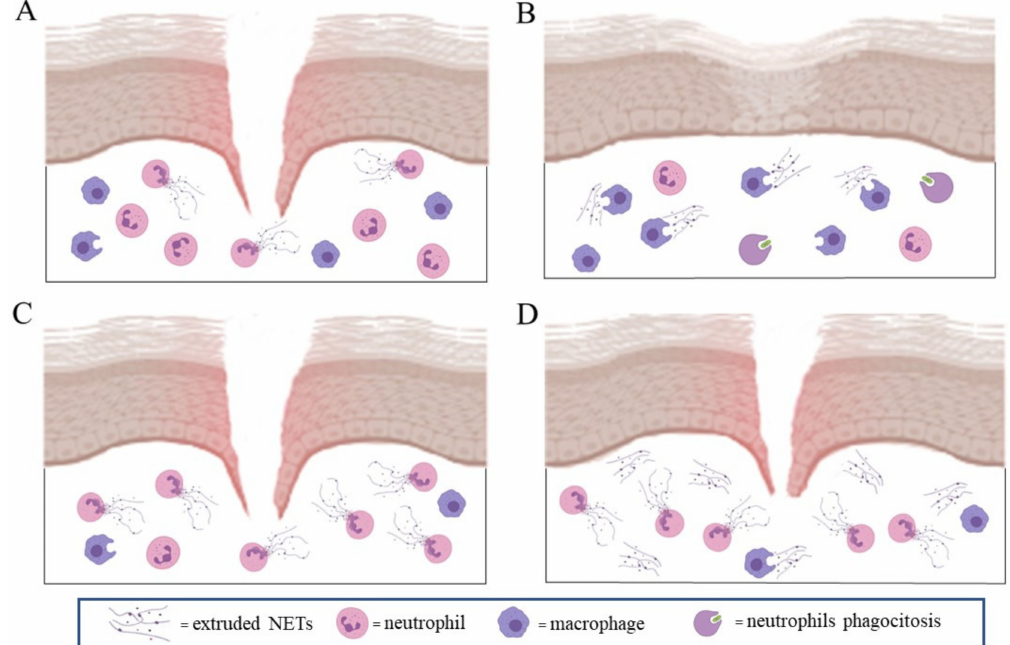
Figure 3. NETs in wound healing: the physiological release of NETs and macrophage clearance ( A ) actions are essential to support the physiological response of fibroblasts and keratinocytes to heal wounds ( B ). Excessive NETs extrusion and inefficient macrophage clearance ( C ) increases in situ inflammation and altered both fibroblast and keratinocyte pro-healing action ( D